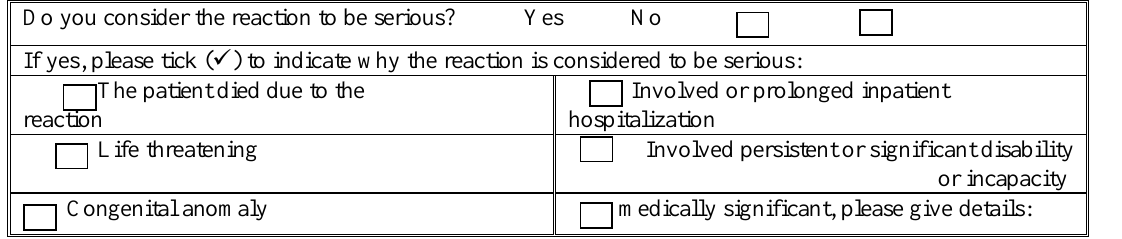
Table 4. Seriousness assessment in the Individual Case Safety Report (20)